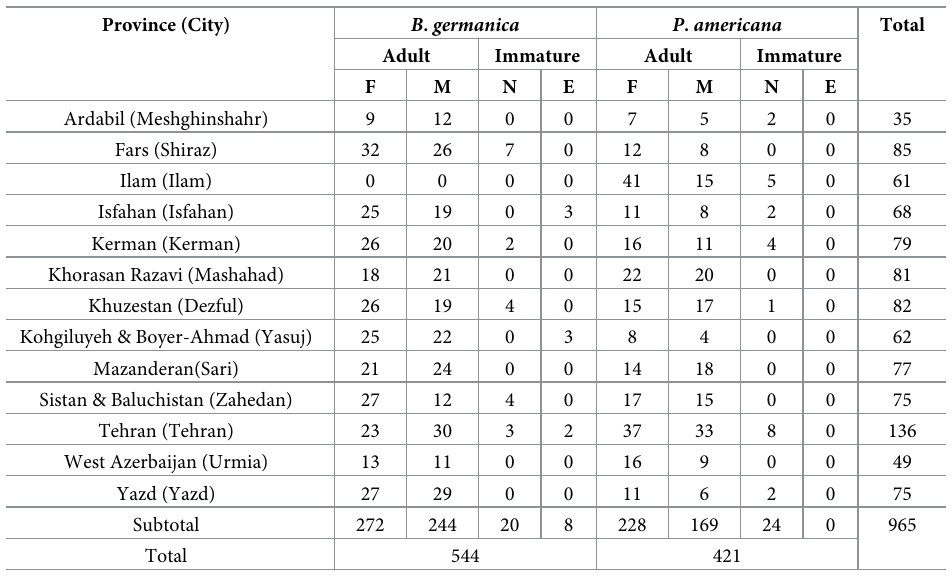
Table 1. Details of cockroach specimens collected in this